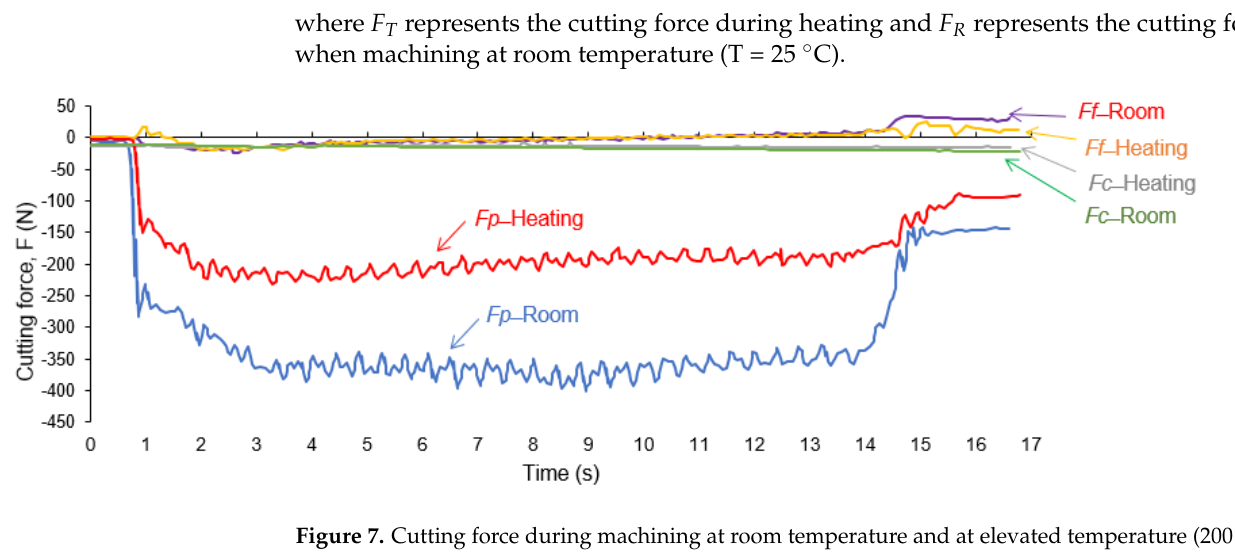
Table 2. Average cu tt ing force at room and elevated temperature .